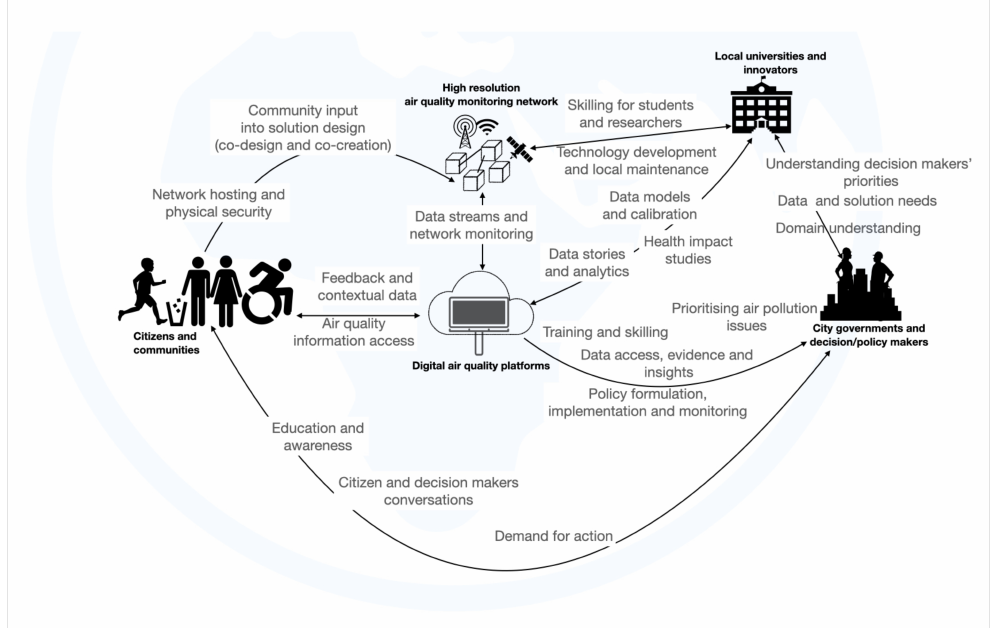
Figure 1. A conceptual design of an air quality sensing and management system urban